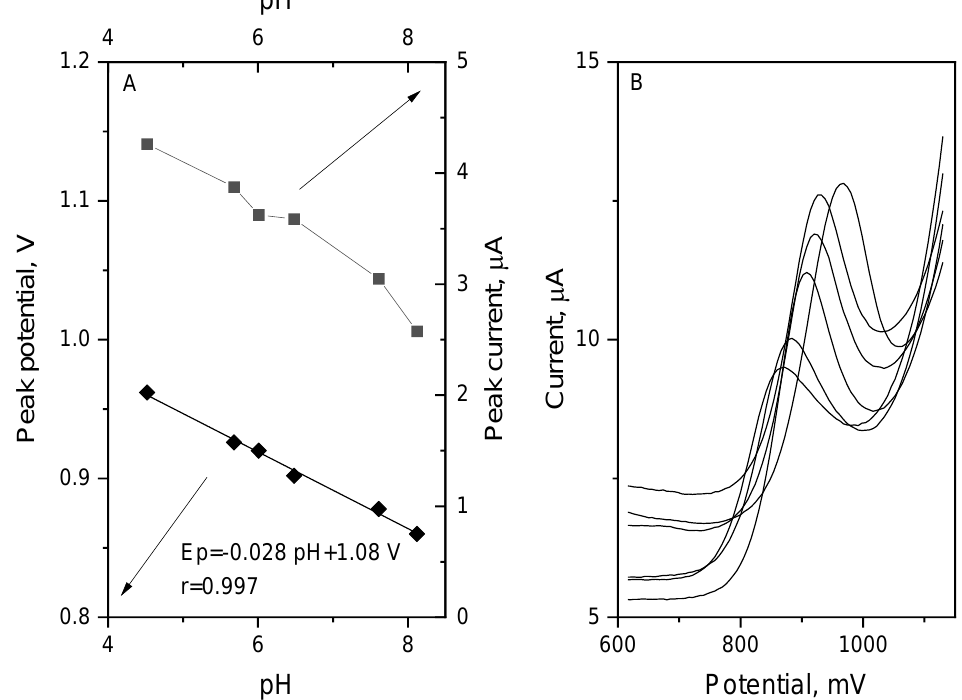
Figure 4. Dependence of the VOR peak current and potential on pH ( A ) and corresponding voltammograms ( B ) measured for the pH values from the range 4.5–8.1 for 1 µ mol L − 1 of VOR in 0.1 mol L − 1 phosphate buffer. Other parameters are as in point 2.7.